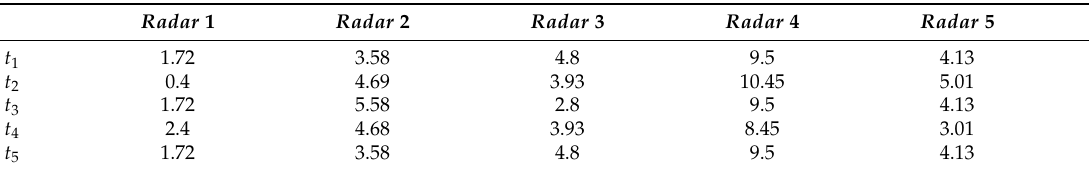
Table 5. Distance between five radars and the target at five moments when the target moves along